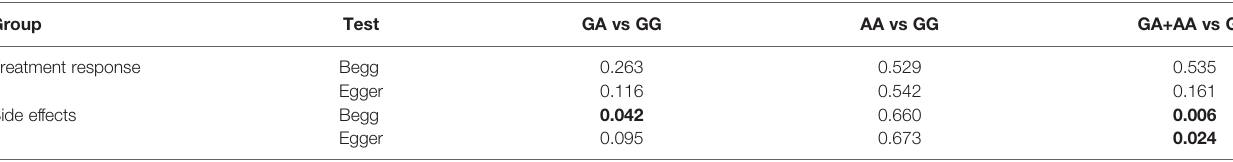
TABLE 5 | P value in publication bias.